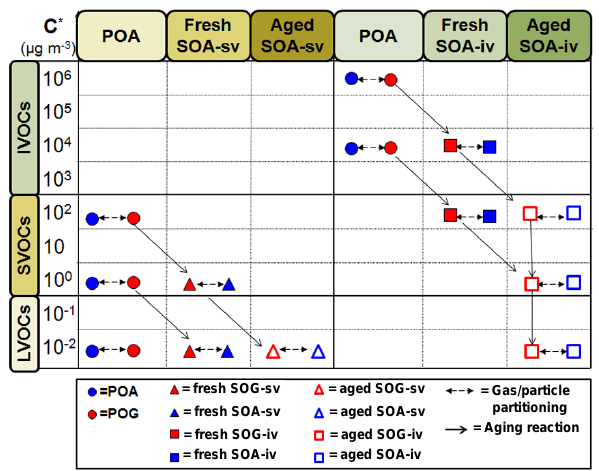
Figure 1. Schematic of the VBS resolution and the formation of SOA from SVOC and IVOC emissions. Red indicates the vapor phase and blue the particulate phase. The circles represent primary organic material that can be emitted either in the gas or in the aerosol phase. Filled triangles and squares indicate the formation of SOA from SVOCs and IVOCs, respectively, by fuel combus- tion and biomass burning sources from the first oxidation step (fresh SOA). Open triangles and squares represent SOA formed in addi- tional oxidation steps (aged SOA) from SVOCs and IVOCs by the same sources. The partitioning processes, the aging reactions of the organic compounds, and the names of the species used to track all compounds are also